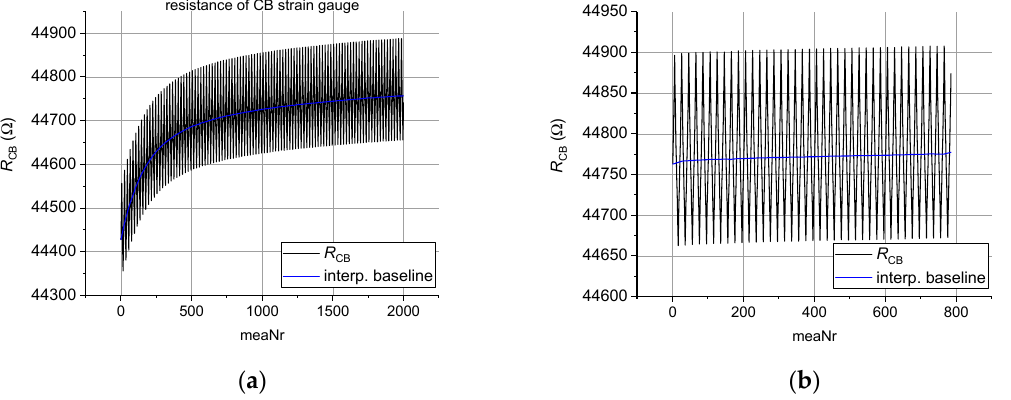
Figure 3. ( a ) Long-term measurement of 100 cycles for carbon black based strain gauge at a constant temperature of 25 °C and 25% RH in a climate chamber. Only after about 90 out of 100 cycles, where one cycle amounts to 20 data points, the gauge factor becomes more stable; ( b ) Second long-term measurement for the same carbon black sample as in Figure 3a. The second run shows that the set-in period is